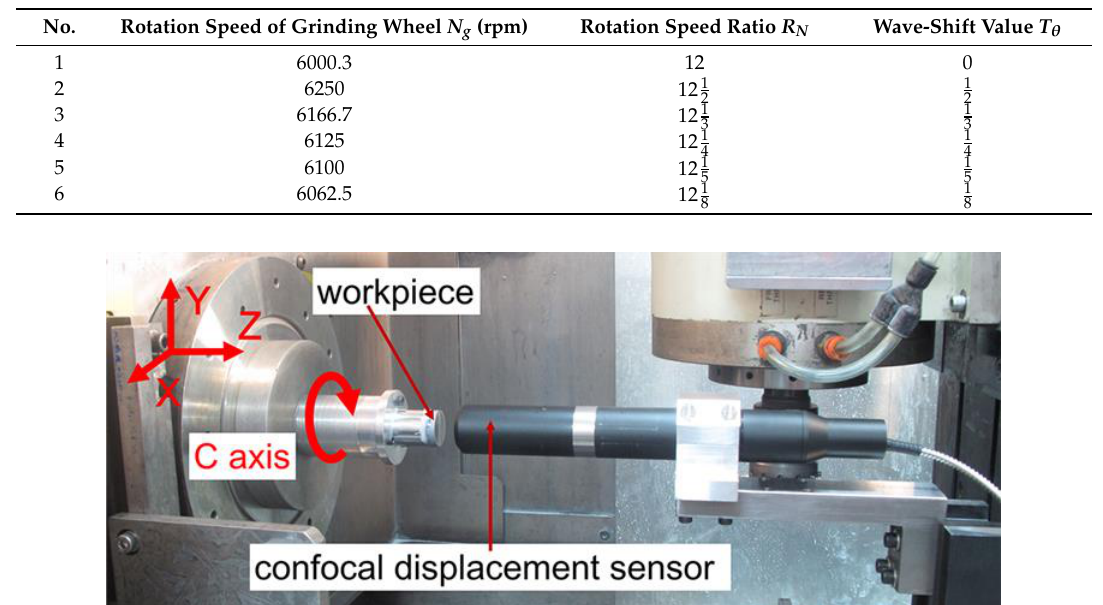
Table 2. Experiment parameters design.